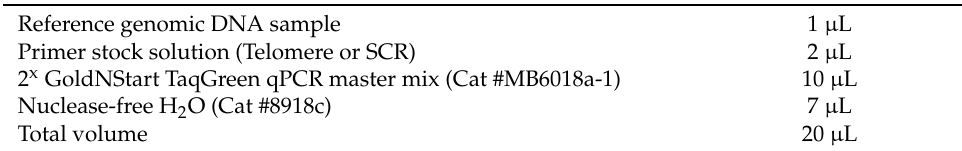
Table 2. Items used for the ScienCell’s Absolute Human Telomere Length Quantification qPCR assay. Reference genomic DNA sample